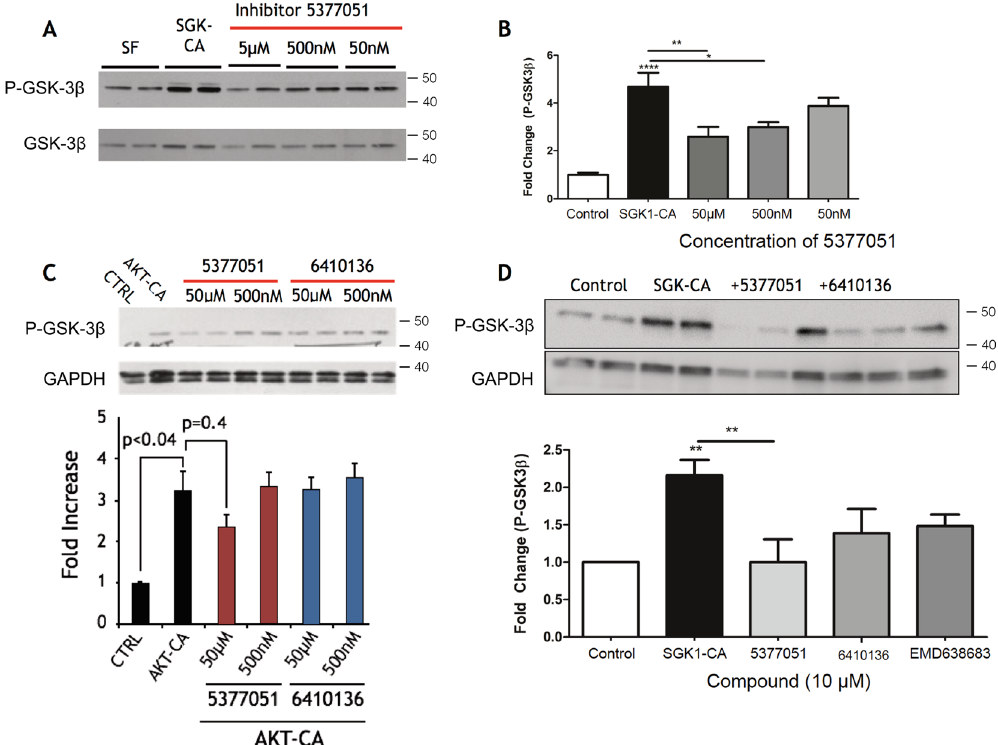
Figure 2. Inhibition of SGK1 in cultured cardiomyocytes by lead compounds. ( A ) Inhibition of SGK1 activity assessed by GSK3 β phosphorylation in CMs infected by Ad.SGK1-CA. ( B ) Different concentrations of 5377051 were assessed at 48 hours after treatment with immunoblotting (left) and quantitated (right). ( C ). Effect of SGK1 inhibitors on Akt-induced phosphorylation of GSK3-beta in CMs infected by Ad.-myr-Akt was assessed by immunoblotting. ( D ) Comparison of potency of 10 micromolar compounds 5377051, 6410136 with the published inhibitor EMD63863. Immunoblots were cut to facilitate the incubation the same samples with multiple antibodies and cropped for clarity. All samples were loaded contiguously as shown. Quantified data are the composite of three independent experiments, each with three technical replicates. Each experimental set was conducted with the same batch of